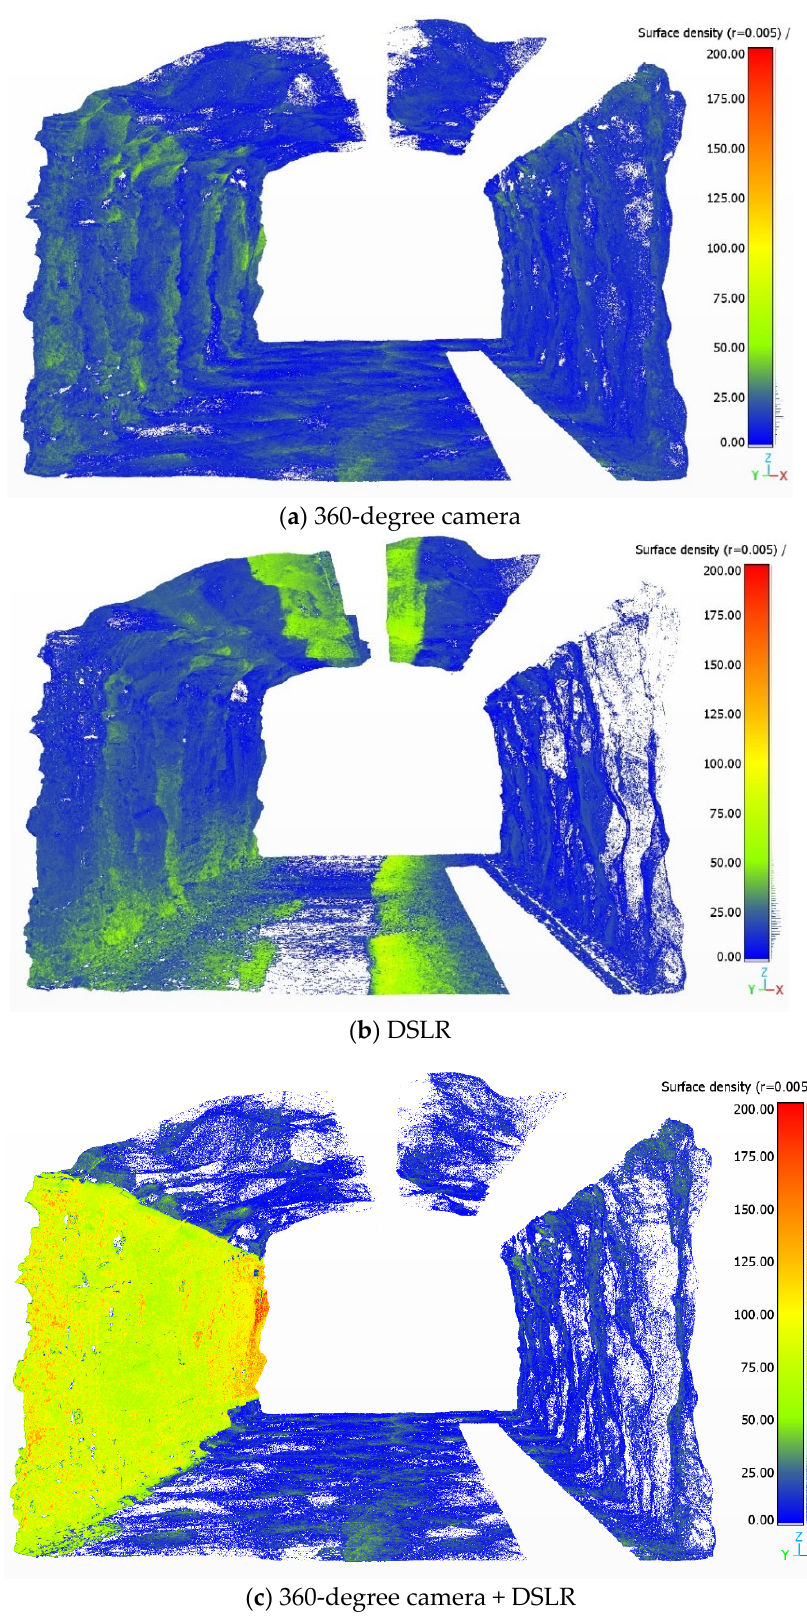
Figure 7. 3D point clouds and surface point density of the tunnel wall digitized with: ( a ) 360 ‐ degree camera ‐ based photogrammetric model, ( b ) DSLR model for comparison, and ( c ) an improved model with additional DSLR images of the tunnel wall.